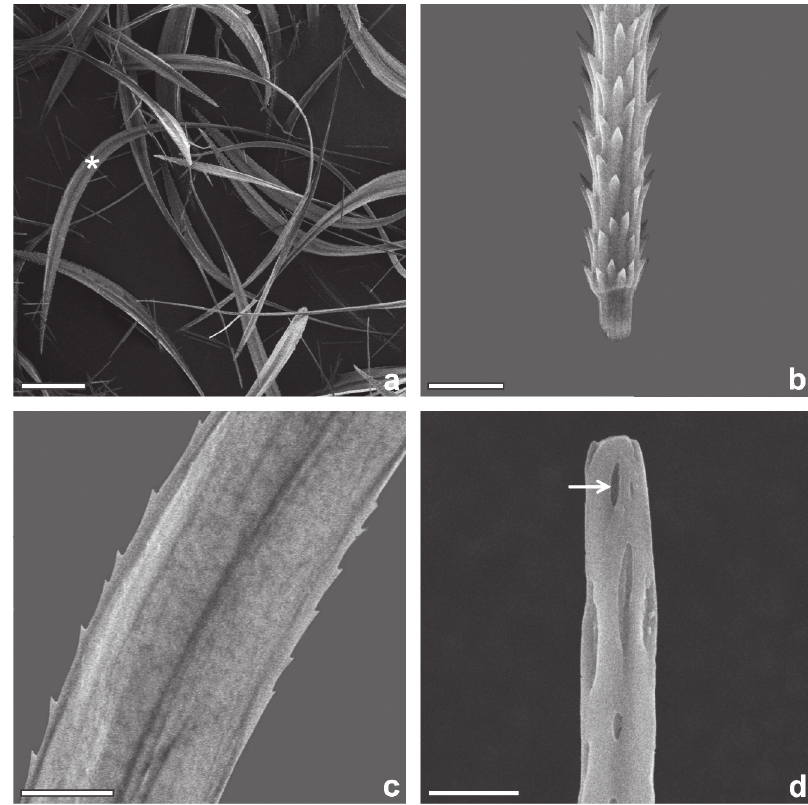
Figure 4 - Modifi ed setae of the female H. oratex . (a) general view (asterisk); (b) pointed projections at base; (c) medial portion; (d) apex, arrow indicates apical orifi ces (scales = 200, 25, 10, 05 µm,